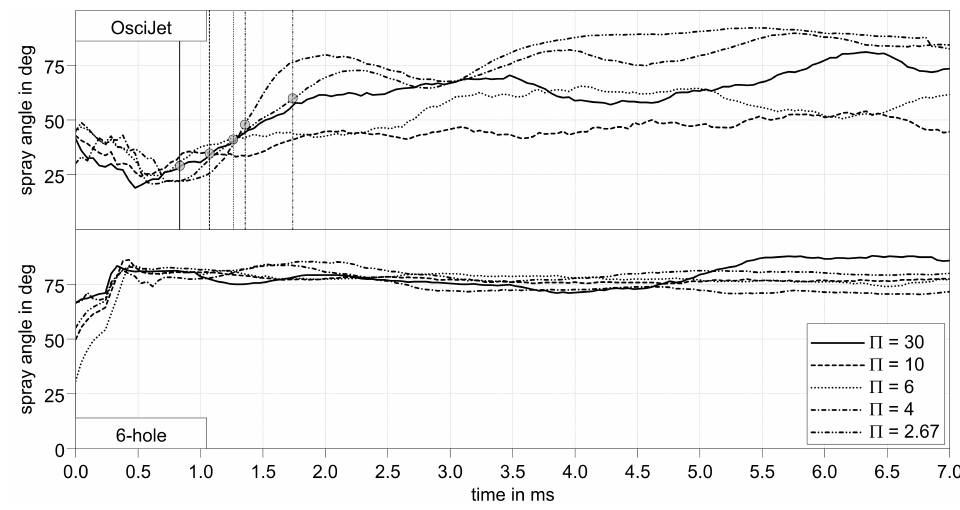
Figure 6. Comparison of spray angles of the two nozzles.